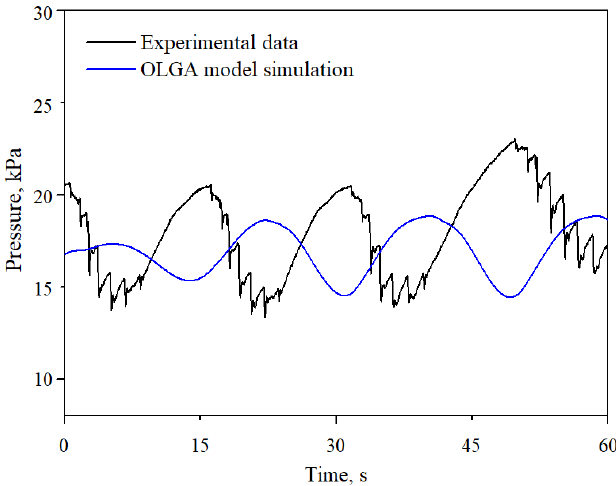
Figure 13. Measured and simulated riser-base pressure profiles of choking-induced slug flow ( U GS = 0.08 m/s and U LS = 0.09 m/s).